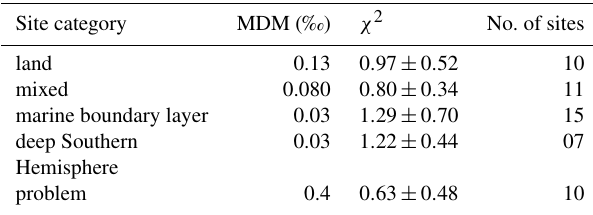
products that include the provider’s original data and meta- data reformatted into the ObsPack framework (Masarie et al., 2014).